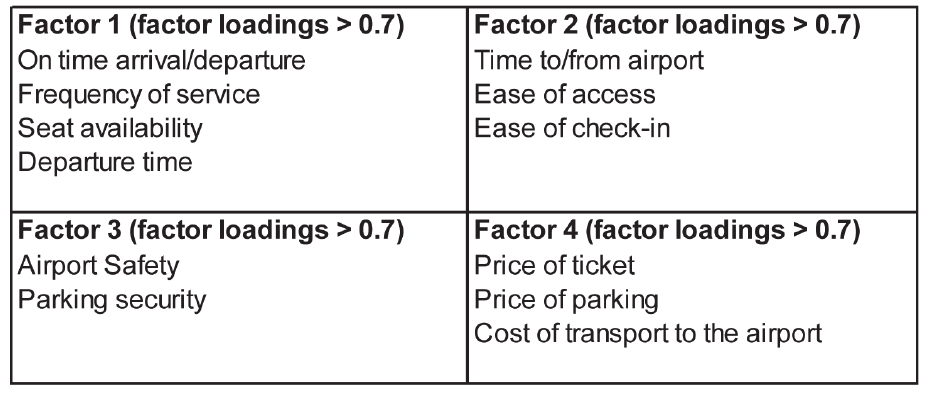
Table 10: Decision